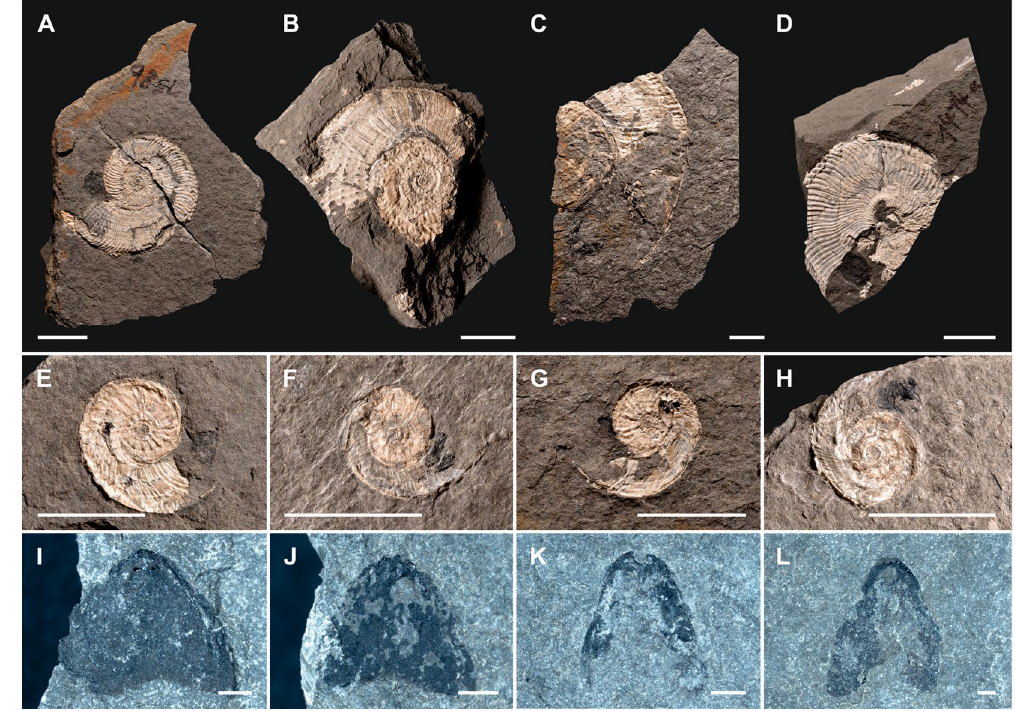
Figure 5. Ammonoid members and in situ anaptychi of the Lower Carnian (Upper Triassic) Polzberg palaeobiota. ( A ) A. minor , positive, lateral view, adult specimen with black Anaptychus lunzenis in front of aperture, NHMW 2021/0123/0141; ( B ) A. minor , lateral view, adult with black A. lunzenis in front of aperture, NHMW 2021/0123/0142; ( C ) A. minor , partly preserved positive, lateral view, adult with black A. lunzenis in anterior part of body chamber, NHMW 2021/0123/0143; ( D ) P. haberfellneri , lateral view, adult with black A. lunzenis in front of body chamber, NHMW 2021/0123/0144; ( E ) A. minor , positive, lateral view, juvenile with black A. lunzenis in front of body chamber, NHMW 2021/0123/0145; ( F ) A. minor , positive, lateral view, juvenile with black A. lunzenis in front of body chamber, NHMW 2021/0123/0146; ( G ) A. minor , positive, lateral view, juvenile with black A. lunzenis in front of body chamber, NHMW 2021/0123/0147; ( H ) A. minor , positive, lateral view, juvenile with black A. lunzenis in front of body chamber, NHMW 2021/0123/0148; ( I ) A. lunzensis , lower jaw, positive, lateral view, isolated specimen, NHMW 2021/0123/0149; ( J ) A. lunzensis , lower jaw, positive, lateral view, isolated specimen, NHMW 2021/0123/0150; ( K ) upper jaw, positive, lateral view, isolated specimen, NHMW 2021/0123/0151; ( L ) upper jaw, positive, lateral view, isolated specimen, NHMW 2021/0123/0152. Scale bars: ( A – H ) 10 mm, ( I – L ) scale bar: 1000 μm. Prepared by AL using CorelDRAW X7; www. corel draw.